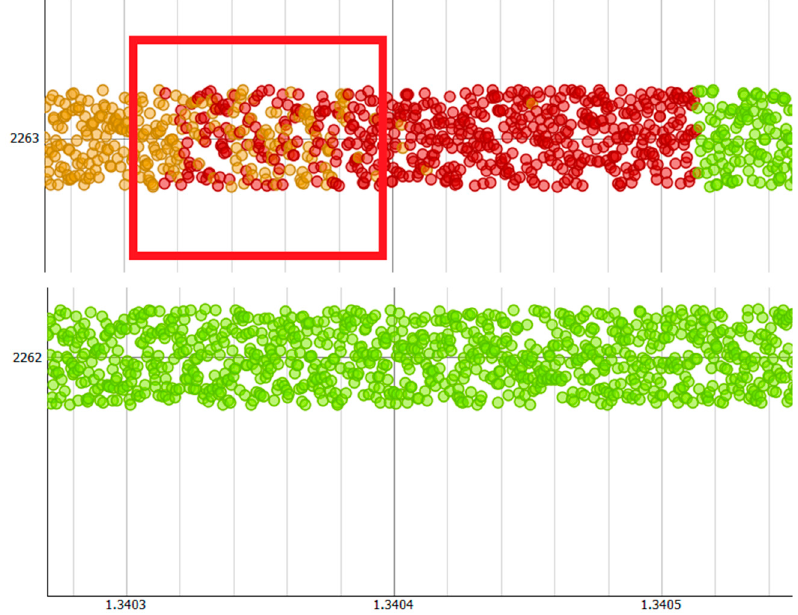
Figure 9. Time series data for various terminal IDs vs. time. Green sections are normal working conditions, amber sections are cloud cover, and red is either disruption or heavy cloud cover affecting signal quality, e.g., 2263.